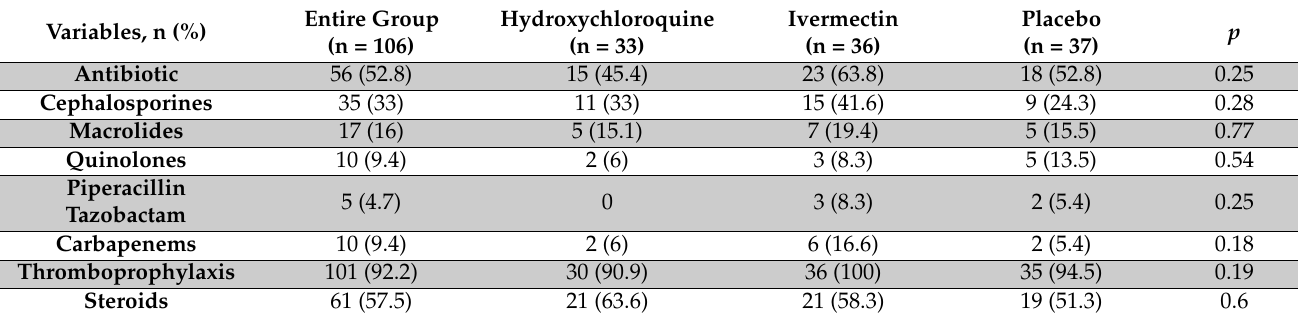
Table 5. Ancillary